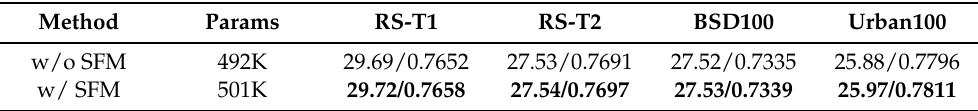
Table 5. Results of our model on four test sets based on whether or not SFM is used. Method Params RS-T1